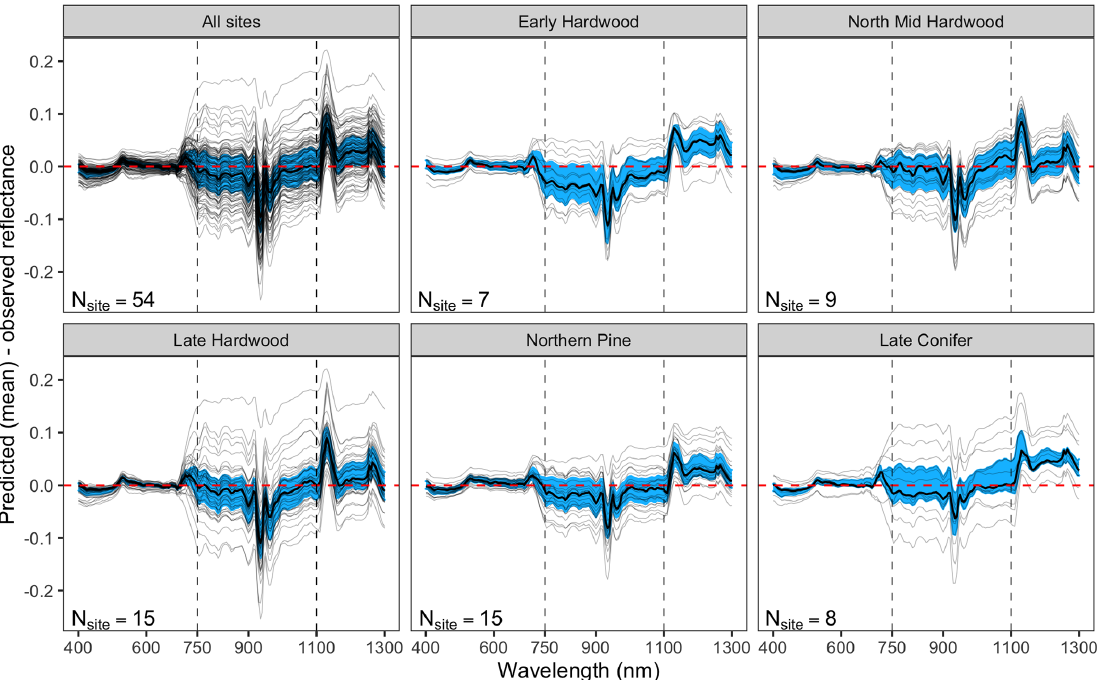
Figure 4. Differences between AVIRIS-observed and EDR posterior predictive mean surface reflectance by site. Each thin gray line is a site-specific AVIRIS observation. Top left panel shows results across all sites, and remaining panels group sites according to dominant PFT. Within each panel, blue shading shows the 25%–75% quantile range and the thick black line is the median by wavelength for that specific site.